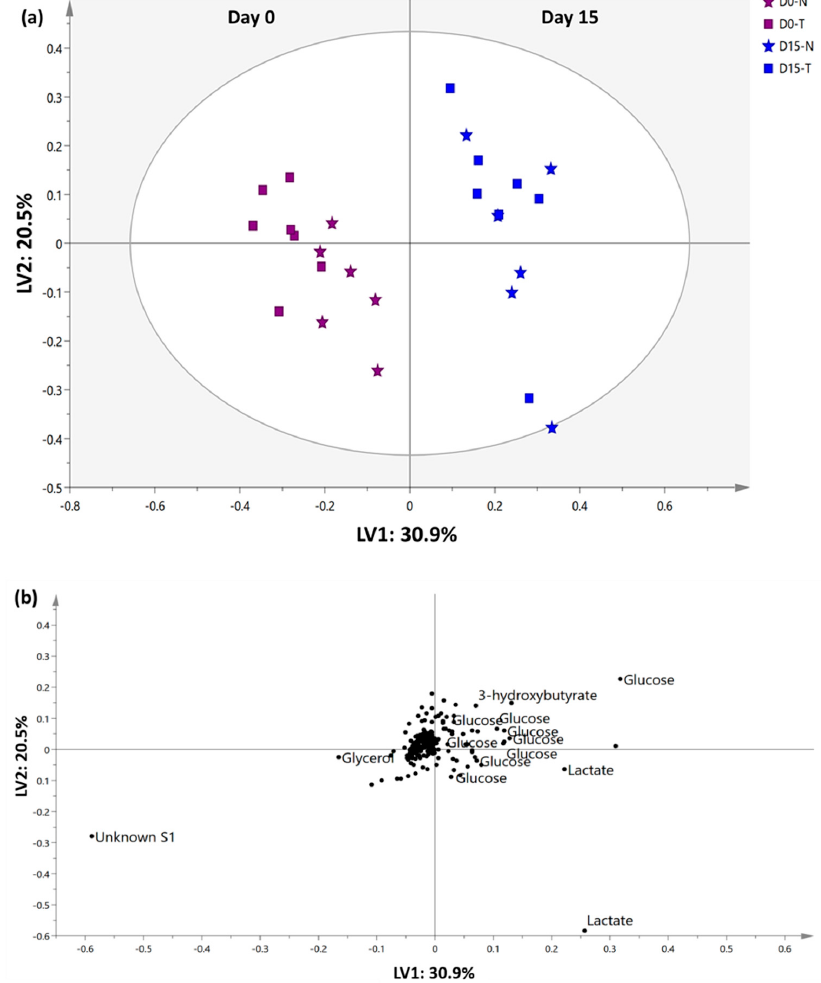
Figure 3. PLS-DA ( a ) score and ( b ) loading plot of serum of untreated and treated rats collected on Day 0 and Day 15. N: untreated rats, T: treated